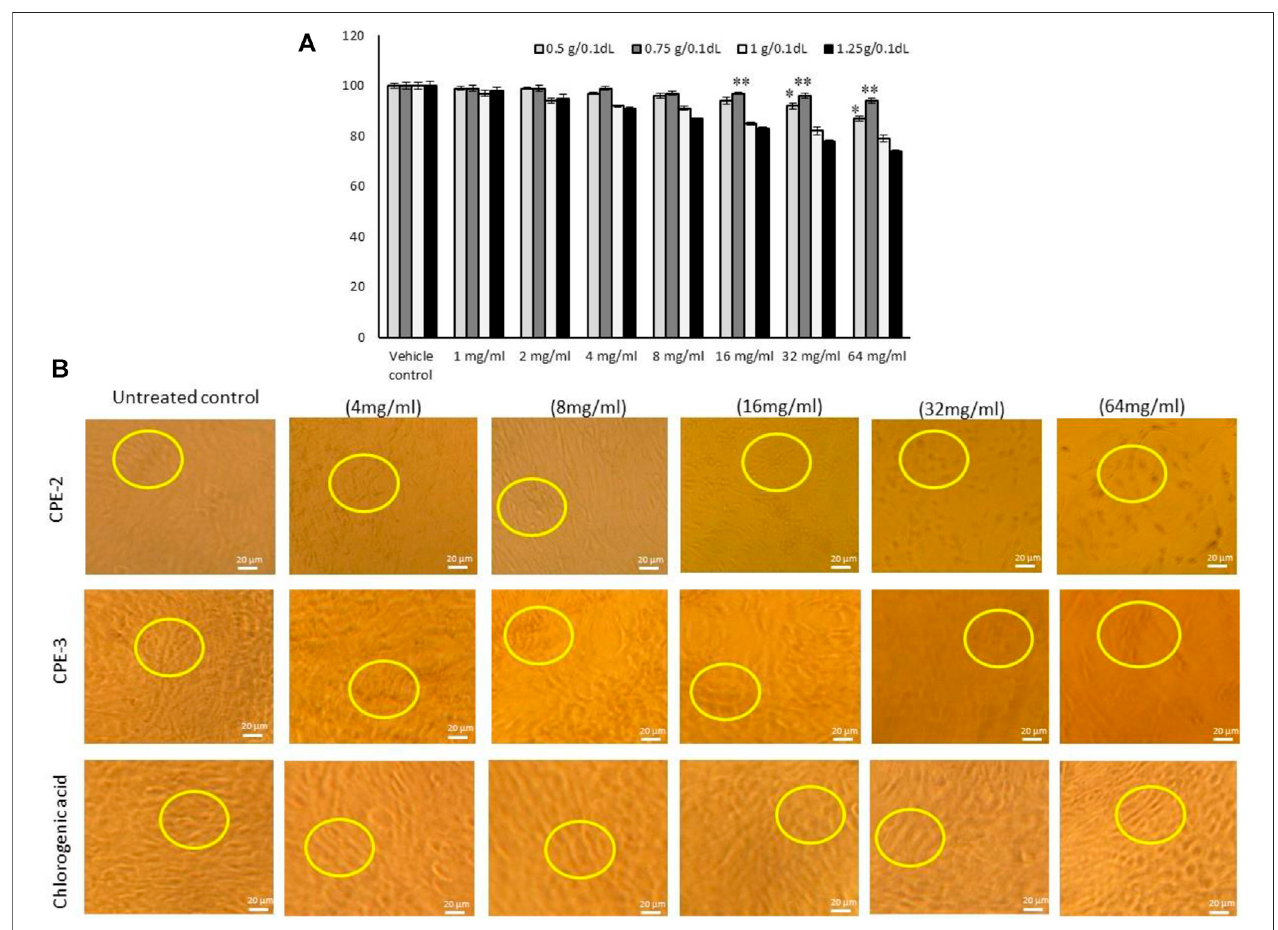
FIGURE4| Invitrocytotoxiceffect (A) andlightmicroscopyimagesforcellmorphology (B) inhMSCstreatedwithincreasingconcentrationofCPEs.Alltheimages were captured with × 10 magni fi cation. CPE-1 (cid:1) 0.5 g, CPE-2 (cid:1) 0.75 g, CPE-3 (cid:1) 1 g, and CPE-4 (cid:1) 1.25 g for 48 h. Each of the values are mean ± SD ( n (cid:1) 6). * p ≤ 0.05 and ** p ≤ 0.001 by comparison with vehicle